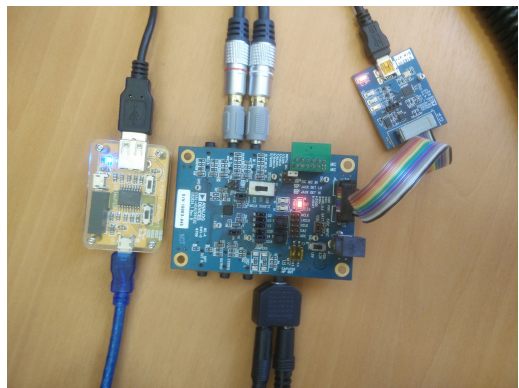
Figure 10. Binaural recording